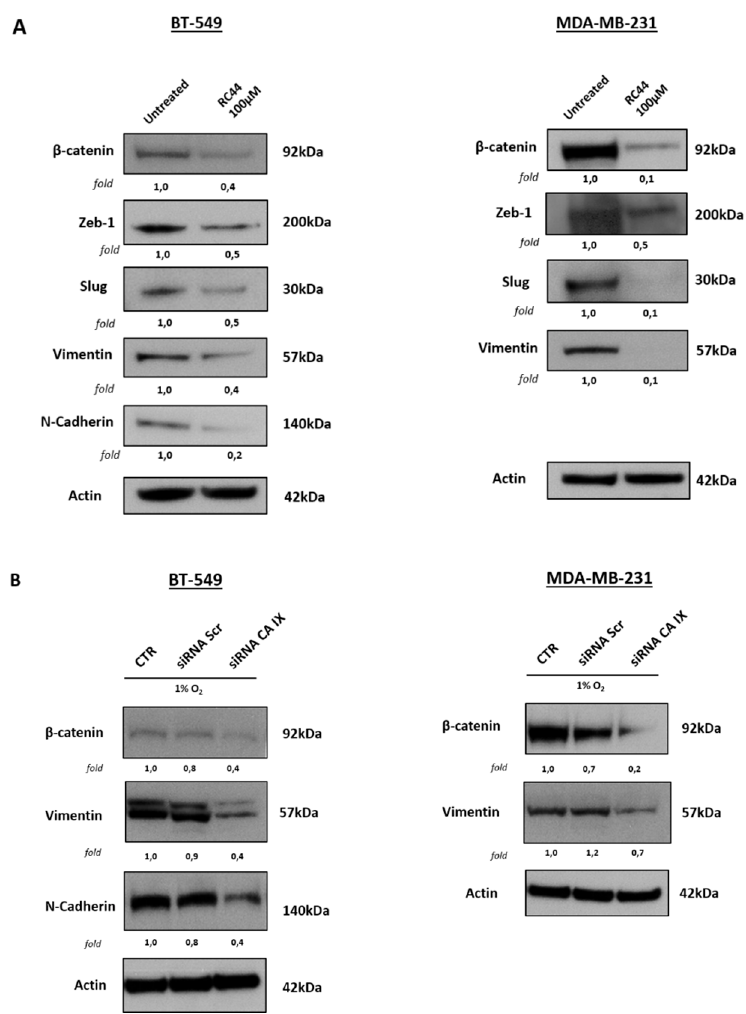
Figure 8. RC44 and CA IX-specific siRNAs reduces signal pathways associated with TNBC plasticity. ( A ) Analysis by Western blot of Vimentin, N-cadherin, β -catenin, Zeb-1 and Slug levels in untreated and RC44 treated BT-549 and MDA-MB-231 cells. ( B ) TNBC cells were transfected for 48 h in hypoxia (1% O 2 ) with CA IX-specific siRNAs (100 nM) or non-targeting siRNAs (siRNA Scr) (100 nM) used as negative control. Vimentin, N-cadherin and β -catenin level protein levels were analyzed using Western blot analysis. Actin was used as loading control. Representative data from one of three experiments are